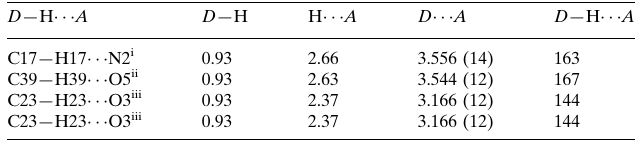
Hydrogen-bond geometry (A˚ , (cid:1)